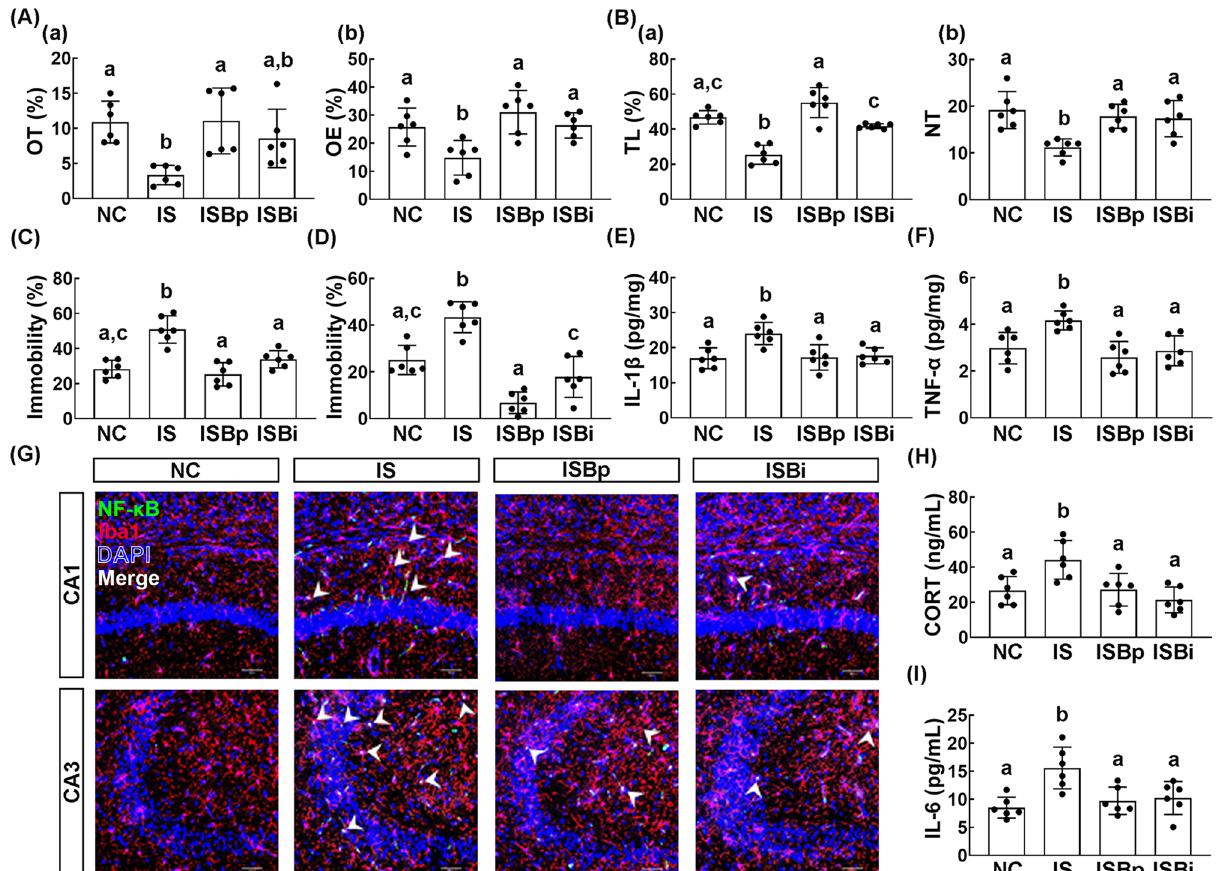
Figure 1. Orally gavage or intraperitoneal injection of buspirone alleviated immobilization stress (IS)-induced anxiety/depression in mice. Effects on IS-induced anxiety/depression-like behaviors in EPM (( A ) a: time spent in the open arm [OT]; b: open arm entries [OE]), LDT (( B ) a: time spent in the light box [TL]; b: number of transition into the light box entry [NT]), TST ( C ), and FST ( D ). Effects on IL-1β ( E ) and TNF-α expression ( F ) and NF-κB + /Iba1 + cell population ( G ) in the hippocampus. Effect on corticosterone (CORT, H ) and IL-6